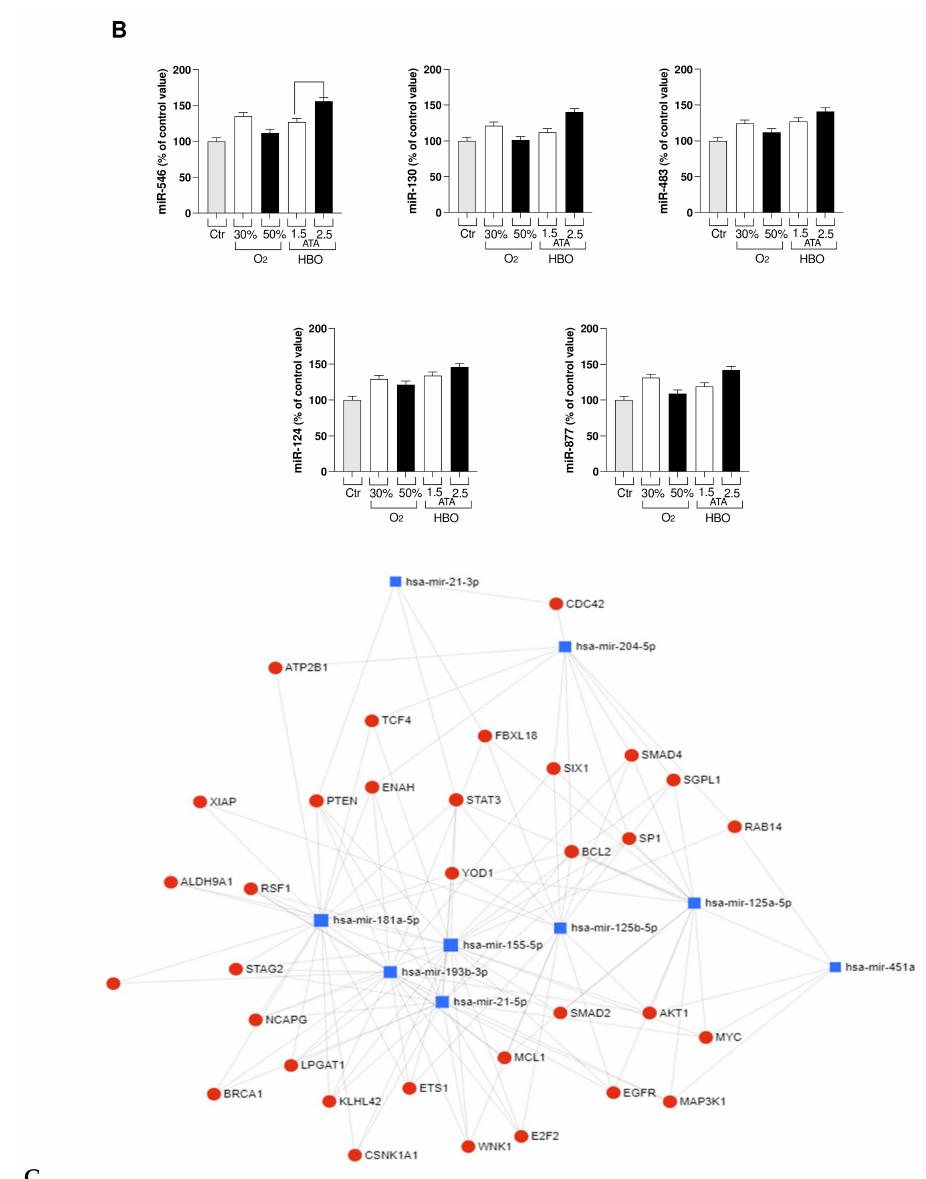
Figure 5. ( A , B ) histogram of gene expression related to miRNA involved on macrophages polariza- tion M2 ( A ) and M1 ( B ). Results are reported as % of variation of T2 compared to T1. Control is basal line. Map ( C ) of pathway involved by the